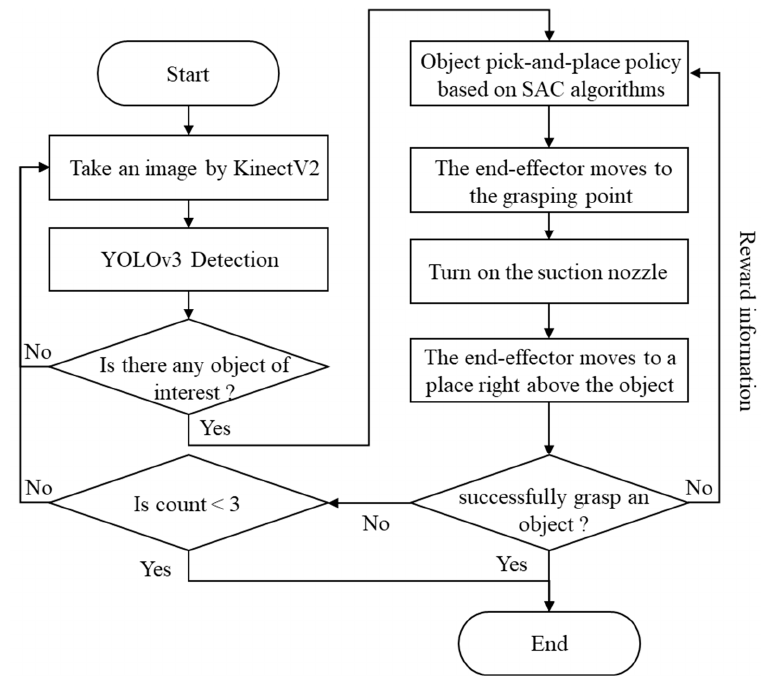
Figure 16. Flowchart for grasping a specific object.